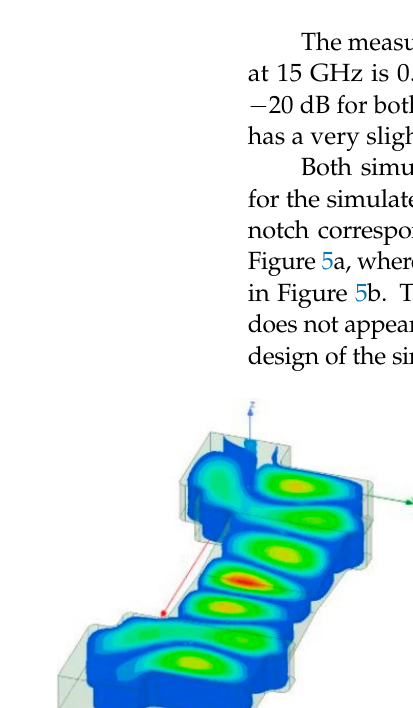
Figure 4. Simulated and measured S-parameters of the TE10-TE20-TE10 back-to-back converter. ( a ) Transmission coefficient |S 21 | and ( b ) reflection coefficient |S 11 | .